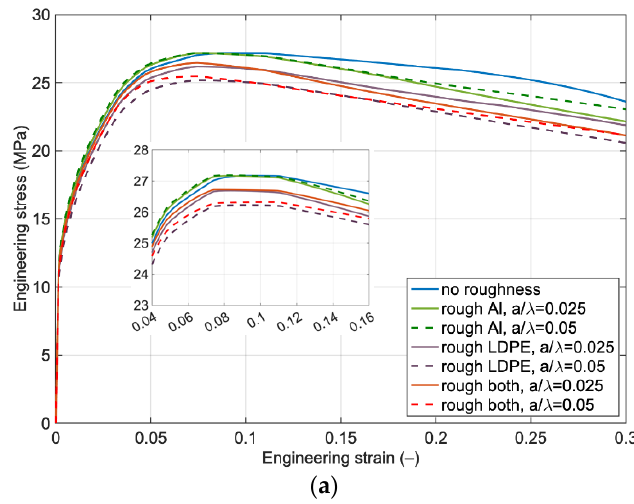
Figure 4. Polymer-supported Al film with an idealized sinusoidal interface: ( a ) wavy LDPE surface with flat Al surface; ( b ) wavy both Al and LDPE surface and ( c ) wavy Al surface with a flat LDPE